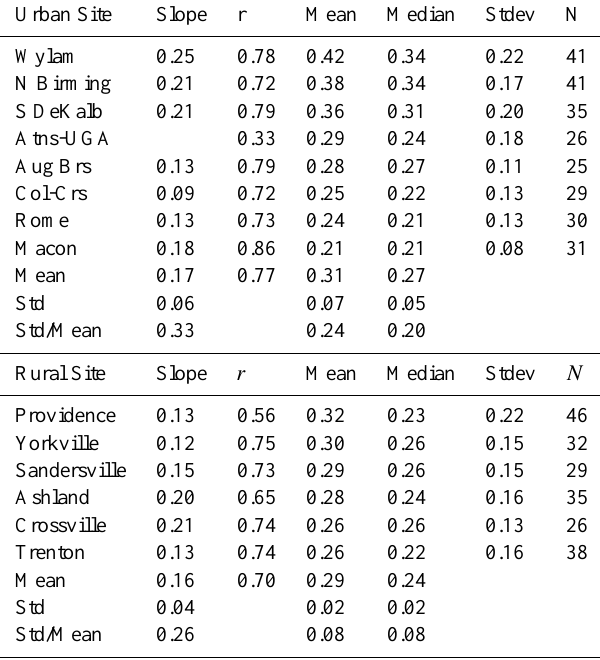
Table 2b. Levoglucosan < 50ngm − 3 (mostly Summer